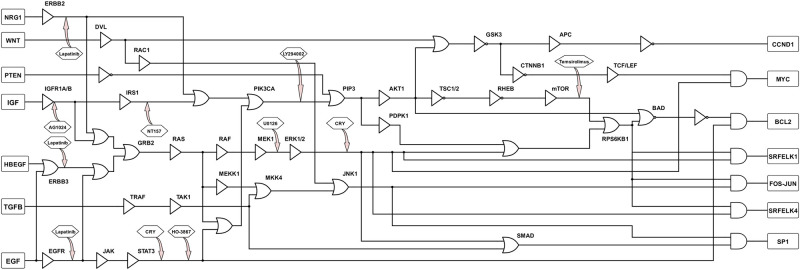
Boolean equivalent of colorectal cancer pathway.Using appropriate boolean rules, we modeled the interactions among different genes in CRC using boolean logic functions.